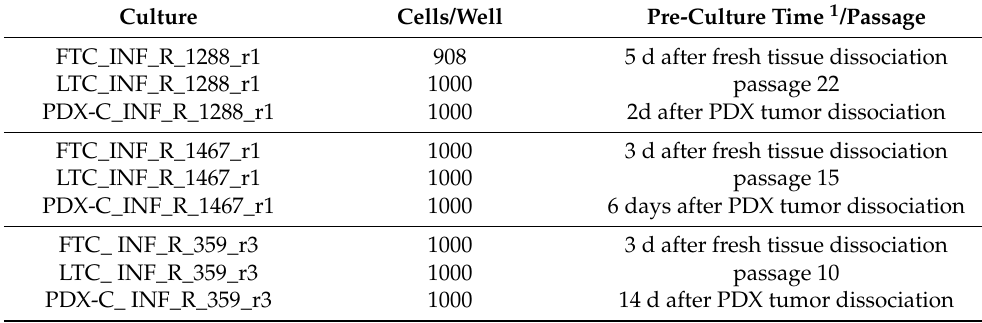
Table 1. Cell numbers and pre-culture time/passage number at drug